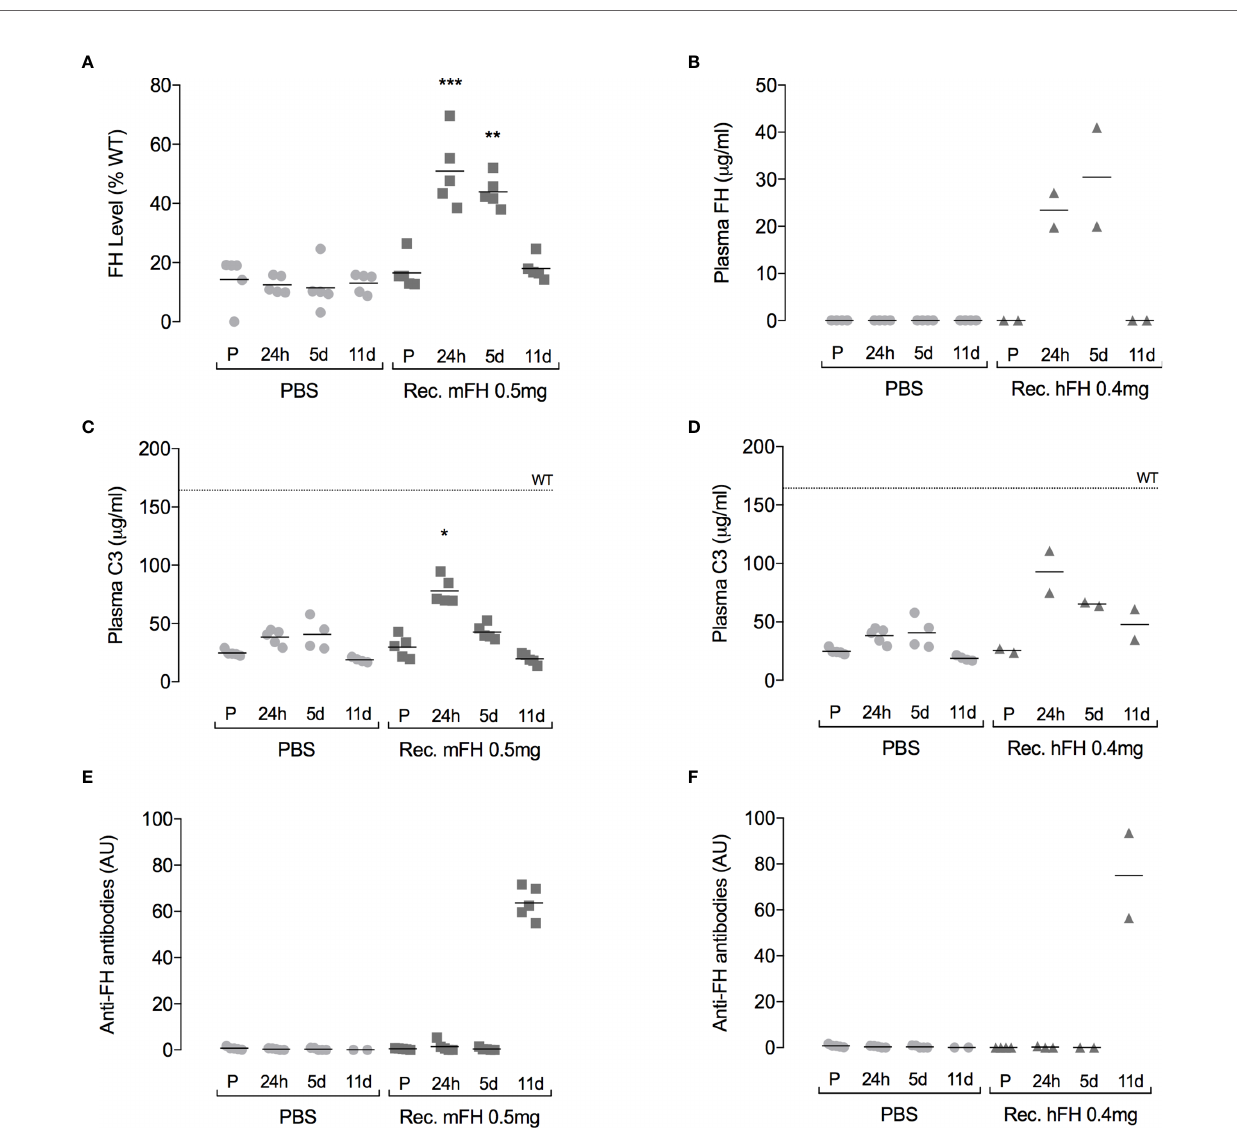
FIGURE 6 | Plasma complement pro fi le following daily FH doses. Recombinant versions of (A, C, E) murine FH, or (B, D, F) human FH were administered IP daily to CFH -/- mice for ten days. Plots show FH (A, B) , C3 (C, D) and anti-FH antibody (E, F) levels in plasma, pre-injection (P), and at 24 hours, fi ve days, and 11 days after the fi rst injection. The dotted line (at 165 µg/mL) is mean plasma C3 concentration in wild-type mice, *P=0.0192, **P=0.0255, ***P=0.0033 versus pre-injection values, Dunn ’ s Multiple Comparisons. Horizontal bars denote mean